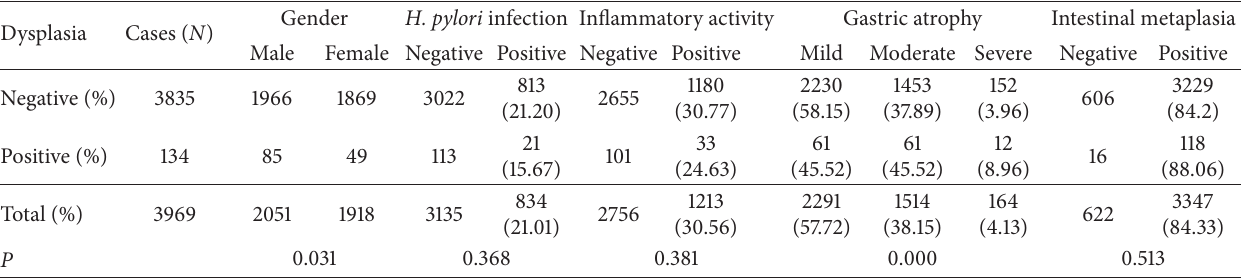
Table 6: The distribution of H. pylori infection, inflammatory (neutrophil) activity, gastric atrophy and intestinal metaplasia according to the presence or absence of